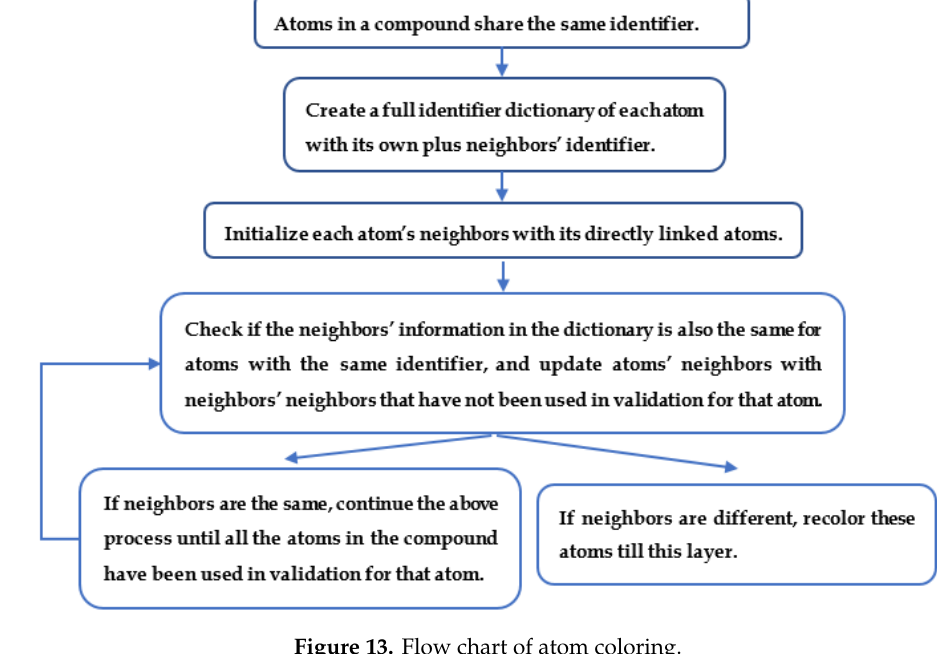
Figure 13. Flow chart of atom coloring.